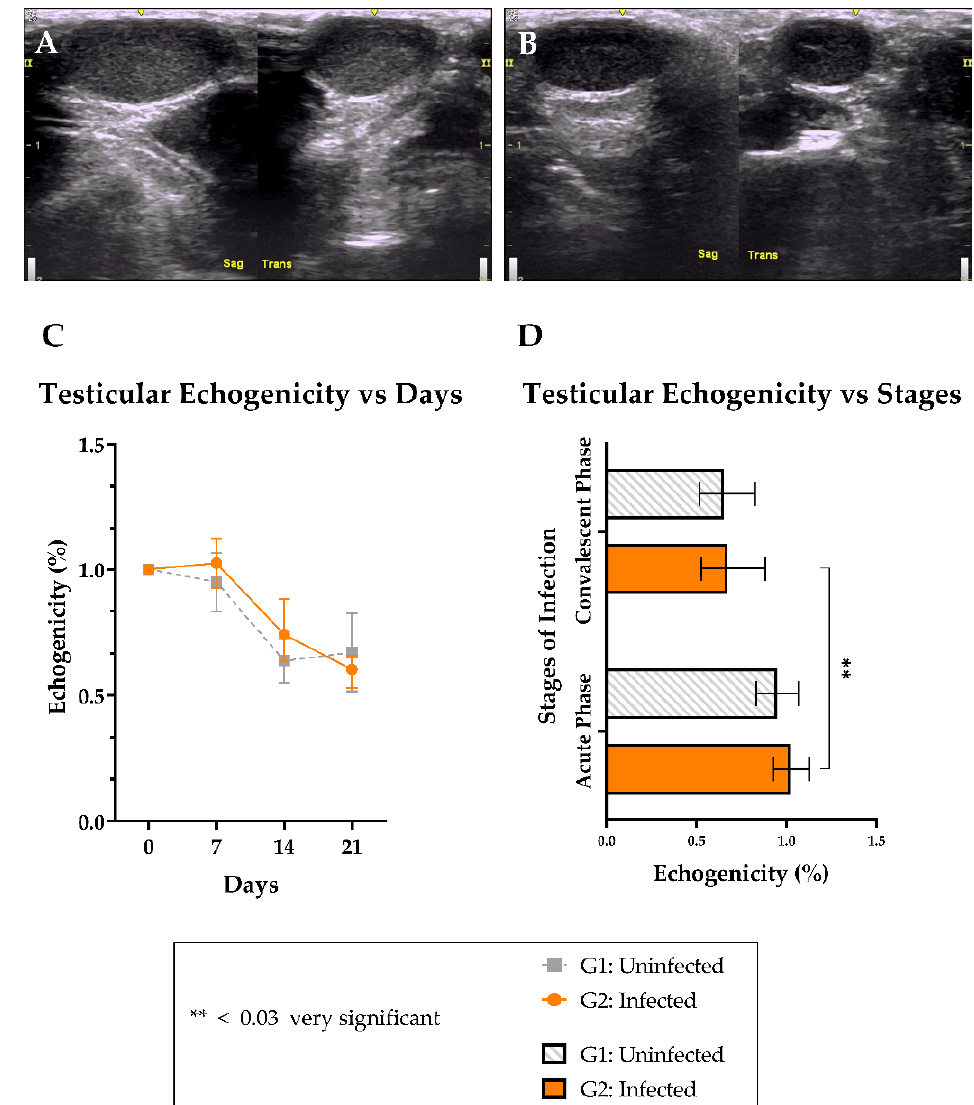
Figure 3. Ultrasonographic analysis at 21 dpi. The left testicle of animal AT-003 (G1) showed normal homogeneity ( A ) and the left testicle of animal AT-163 (G2) presented hypoechoicity in all its extensions ( B ). The testicular echogenicity of G1 and G2 was evaluated at the indicated day ( C ) and by stages of ZIKV infection ( D ). Mean and min-max values.